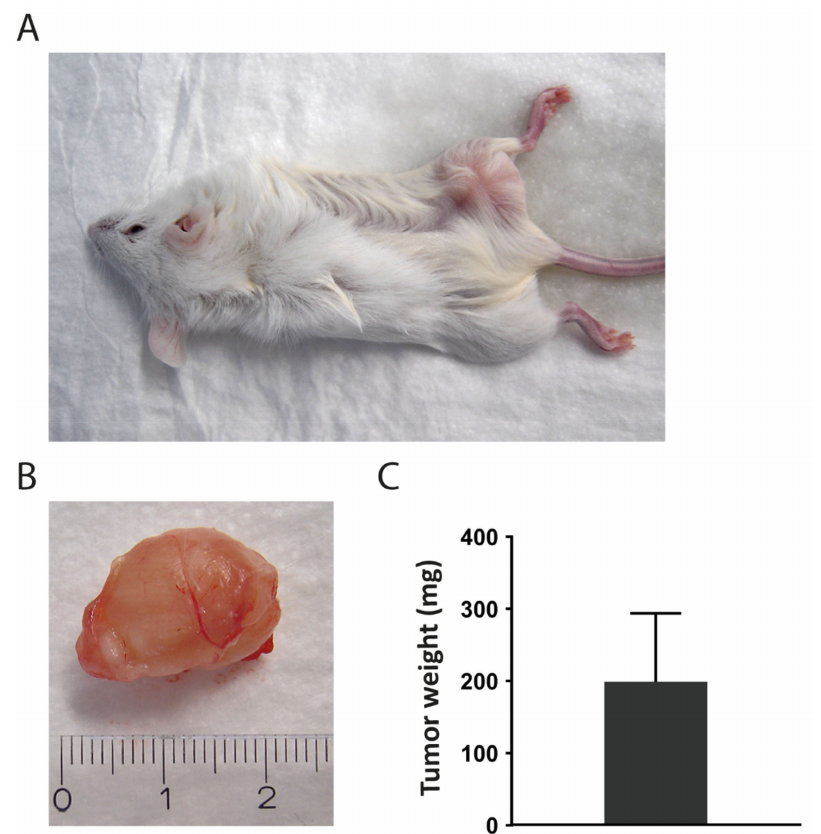
Figure 10. Mouse xenografts after subcutaneous injection of 5 × 10 6 SRH cells. ( A ) Representative image showing a NSG mouse with a subcutaneous tumor nine weeks after inoculation. ( B ) Representative image of a removed tumor. ( C ) Dissected tumors were weighed and the mean weight (mg) with standard deviation was plotted.